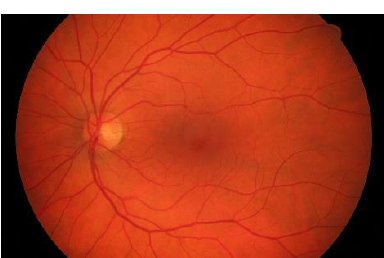
Figure 7.a. Input image